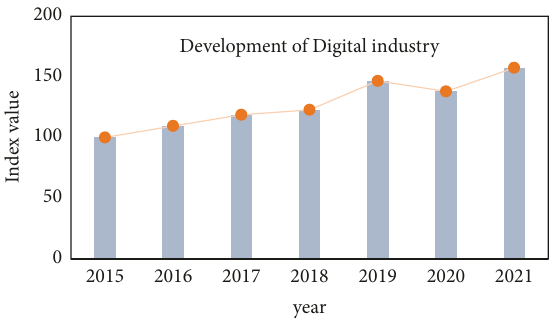
Figure 7: Digital industry development evaluation results.